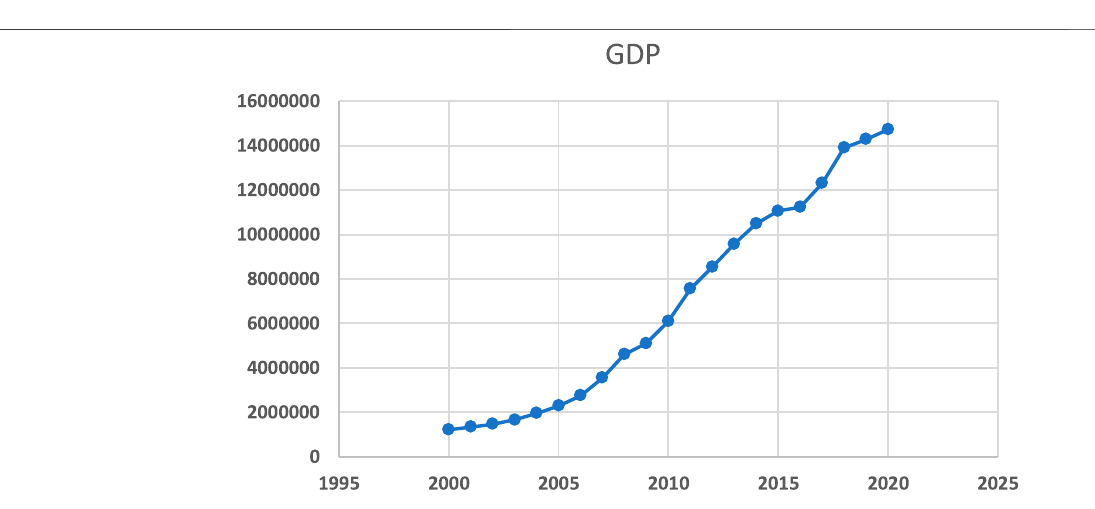
Frontiers in Environmental Science |